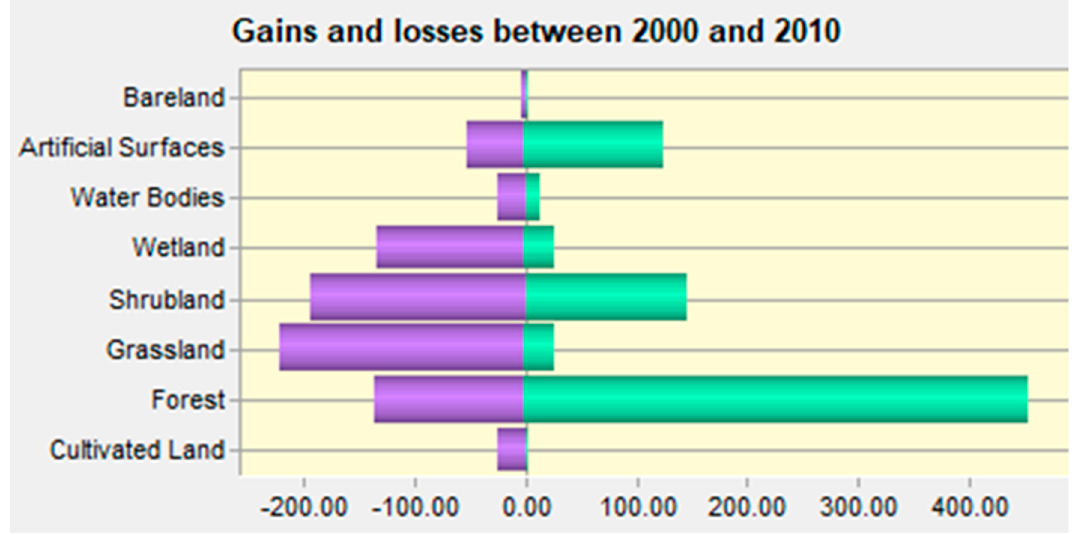
Figure 6. Gains and losses in LULC (km 2 ) between 2000 and 2010.